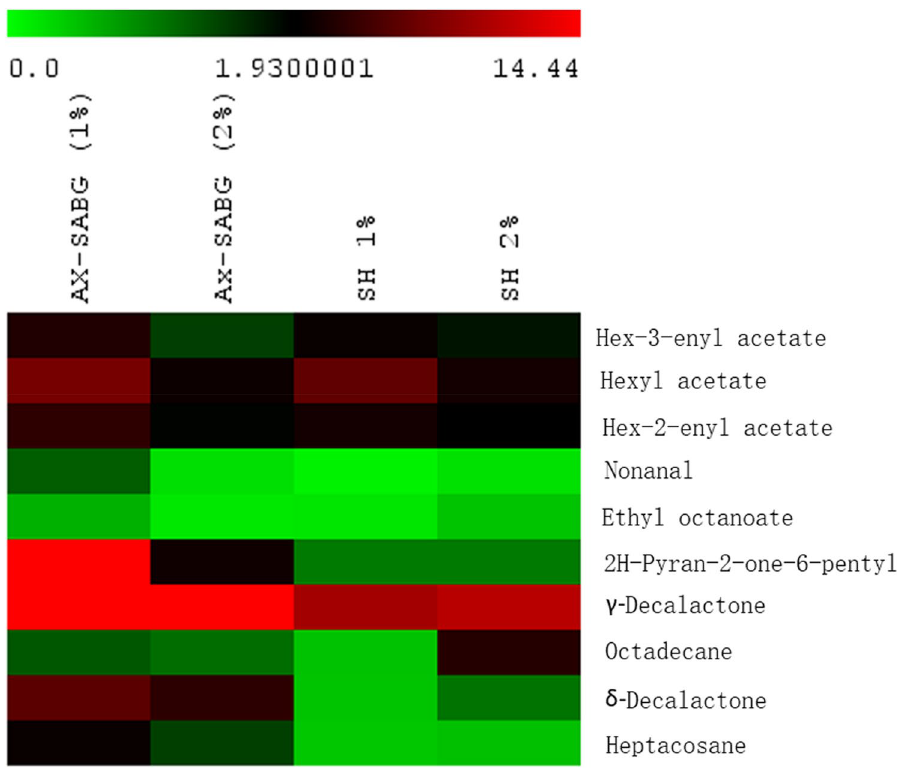
Figure 5. Distribution of volatile compounds in the AX-SABG and shellac (1–2%) coated peaches during storage ( AX‑SABG arabinoxylan-β-d-glucan stearic acid ester, SH